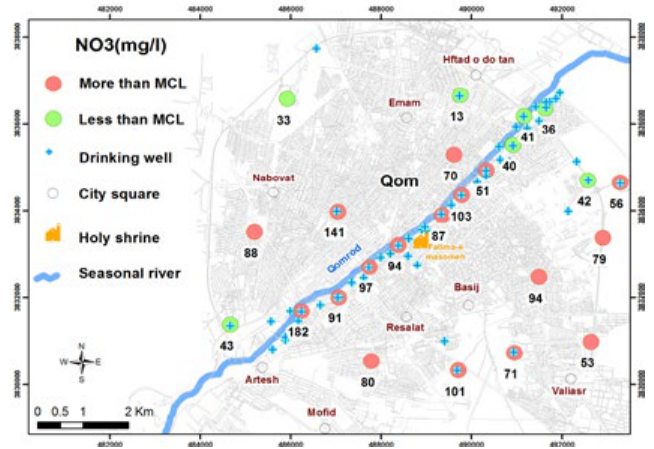
Fig. 5. Groundwater NO